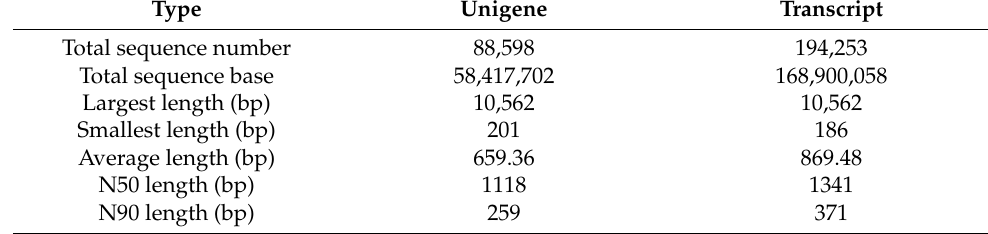
Table 2. Statistics of sequencing and assembly results.